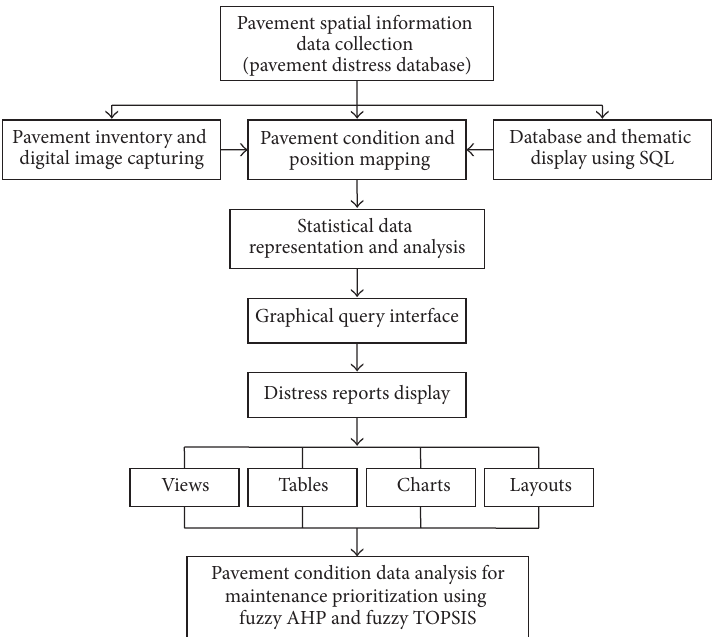
Figure 3: Proposed framework for pavement inventory and condition survey thematic display system.